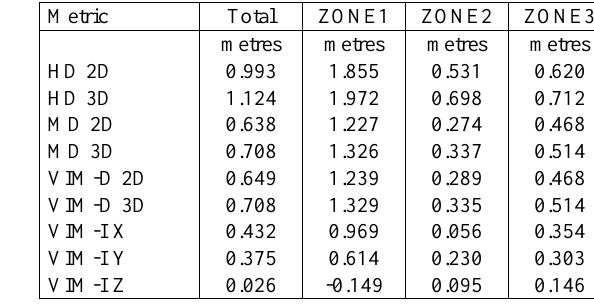
Table 2. Mean results of HD, MD and